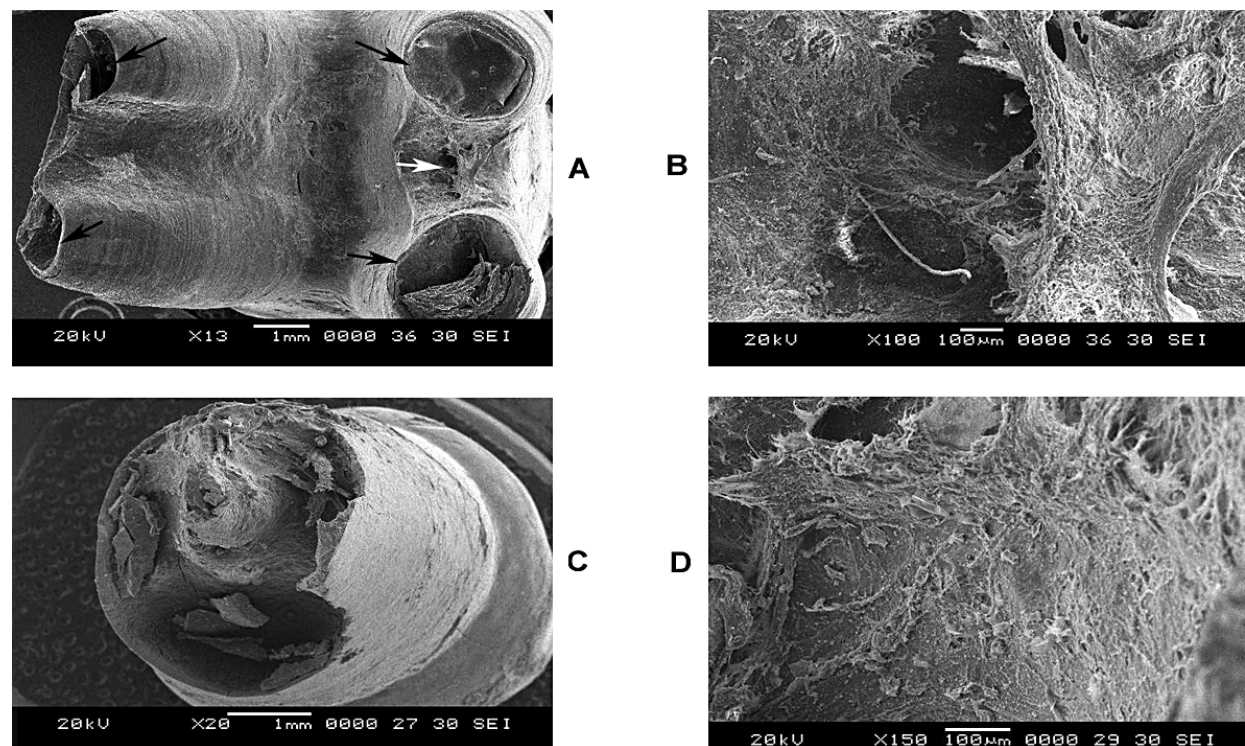
FIGURE 4 (A-D) - Root resorption patterns of a permanent molar (13 and 100x) and a permanent incisor (20 and 150x) associated with odontogenic